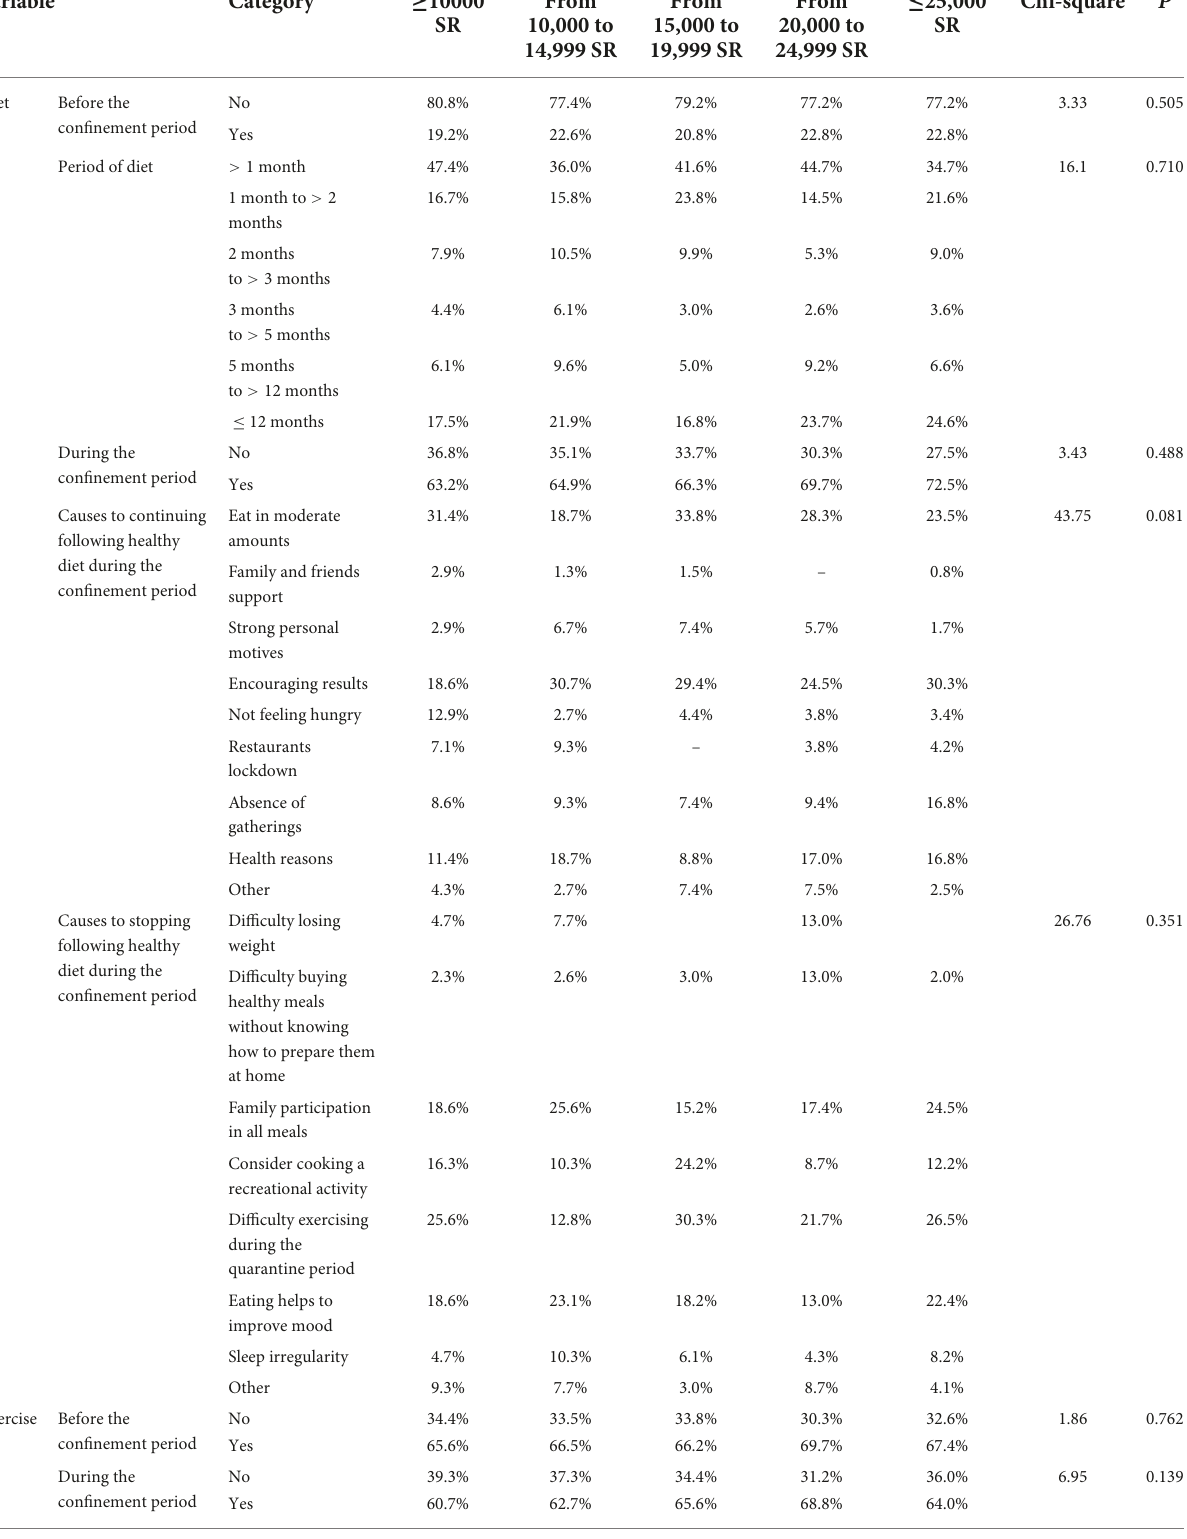
TABLE 5 Income, diet, and exercising before and during the confinement